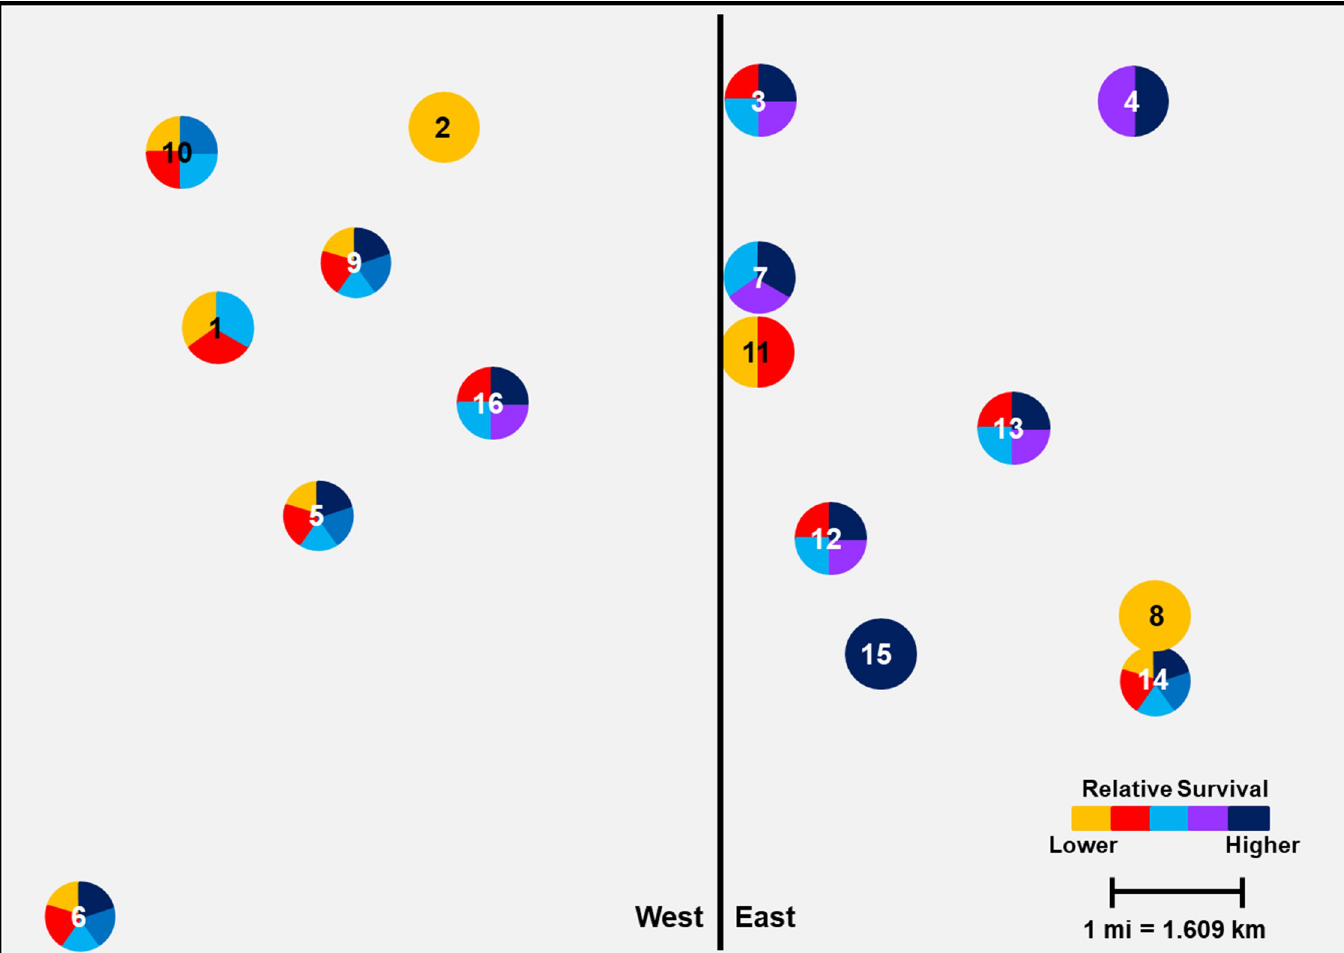
Fig 8. Spatial variation in mean Cry3Bb1 survival of WCR larvae among sampling sites in Buffalo County. Mean proportional survival ranged from 0.07 ± 0.02 to 0.40 ± 0.05. Circles containing the same color(s) are not significantly different (generalized linear model, P > 0.05; LSMEANS